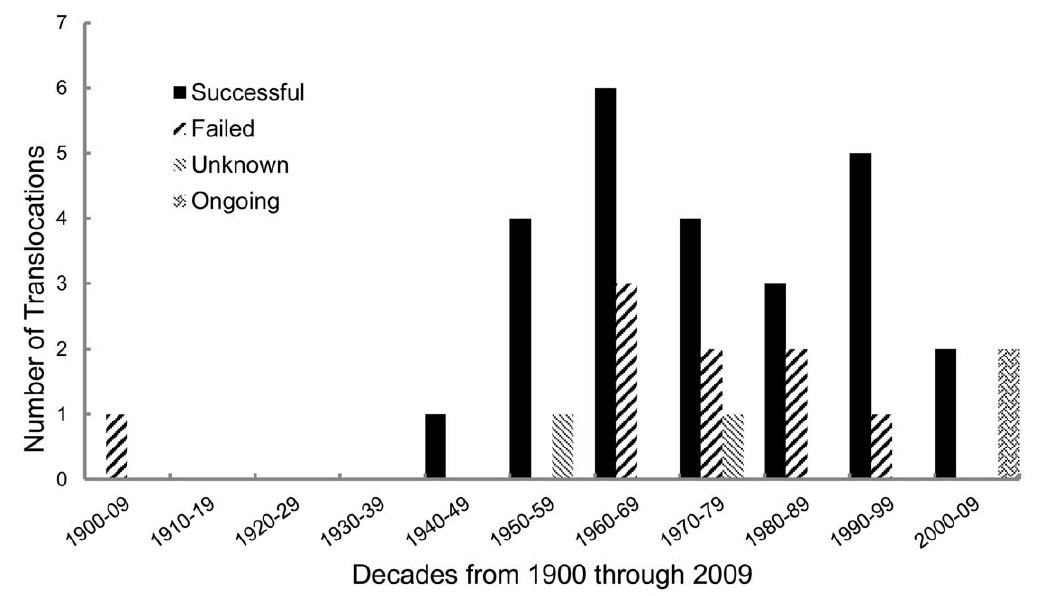
Figure 7. Chronology and success status of 38 fisher translocations.